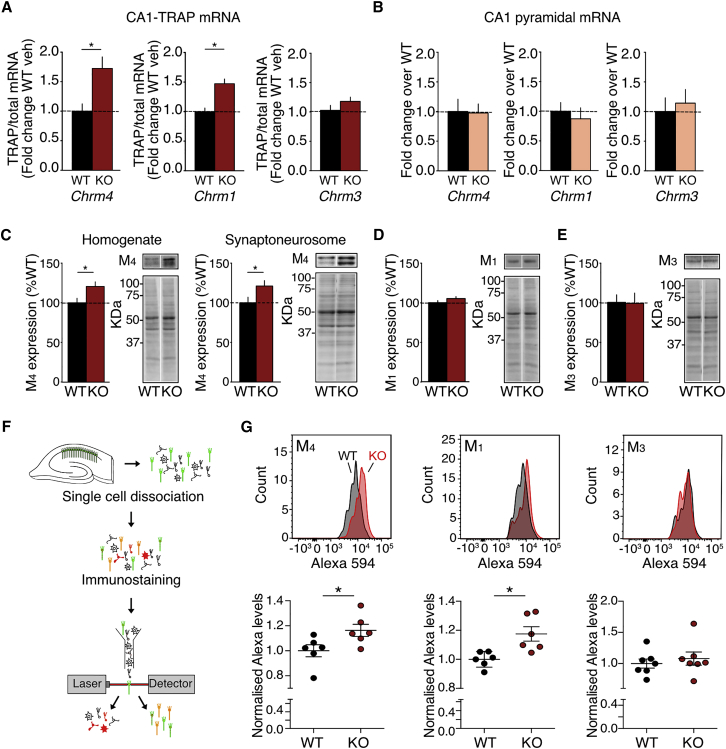
M1 and M4 Are Excessively Synthesized and Overexpressed in Fmr1−/y CA1 Pyramidal Neurons(A) Chrm4 and Chrm1, but not Chrm3, are enriched in the Fmr1−/y CA1-TRAP IP (Chrm4: WT = 1.00 ± 0.124, KO = 1.72 ± 0.195, ∗p = 0.0044, n = 14; Chrm1: WT = 1.00 ± 0.062, KO = 1.47 ± 0.079, ∗p < 0.0001, n = 14; Chrm3: WT = 1.00 ± 0.085, KO = 1.184 ± 0.073, p = 0.192, n = 10).(B) Total mRNA levels of Chrm4, Chrm1 and Chrm3 are unchanged in FACS-isolated Fmr1−/y CA1 pyramidal neurons (Chrm4: WT = 1.00 ± 0.209, KO = 0.98 ± 0.154, p = 0.926, n = 9; Chrm1: WT = 1.00 ± 0.150, KO = 0.87 ± 0.185, p = 0.602, n = 11; Chrm3: WT = 1.00 ± 0.232, KO = 1.14 ± 0.230, p = 0.668, n = 8).(C) Immunoblotting shows overexpression of M4 protein in hippocampal slice homogenates (WT = 100% ± 5.7%, KO = 121% ± 5.7%, ∗p = 0.0186, n = 12) and synaptoneurosomes (WT = 100% ± 7.10%, KO = 121% ± 6.89%, ∗p = 0.0203, n = 9).(D and E) Hippocampal slice homogenates show no difference in M1 (D) (WT = 100% ± 2.5%, KO = 105% ± 2.5%, p = 0.129, n = 12) or M3 (E) (WT = 100% ± 9.5%, KO = 98% ± 12.9%, p = 0.94, n = 9) expression.(F) Schematic shows steps for FACS immunostaining.(G) FACS-immunostaining reveals significant increase in the expression of M4 and M1 (M4: WT = 0.925 ± 0.045, KO = 1.075 ± 0.045, ∗p = 0.0389, n = 6; M1: WT = 0.920 ± 0.002, KO = 1.080 ± 0.046, ∗p = 0.0092, n = 6), but not M3 (WT = 0.962 ± 0.07, KO = 1.038 ± 0.1011 p = 0.547, n = 7), in Fmr1−/y CA1 pyramidal neurons. n = number of littermate pairs. Error bars indicate SEM.